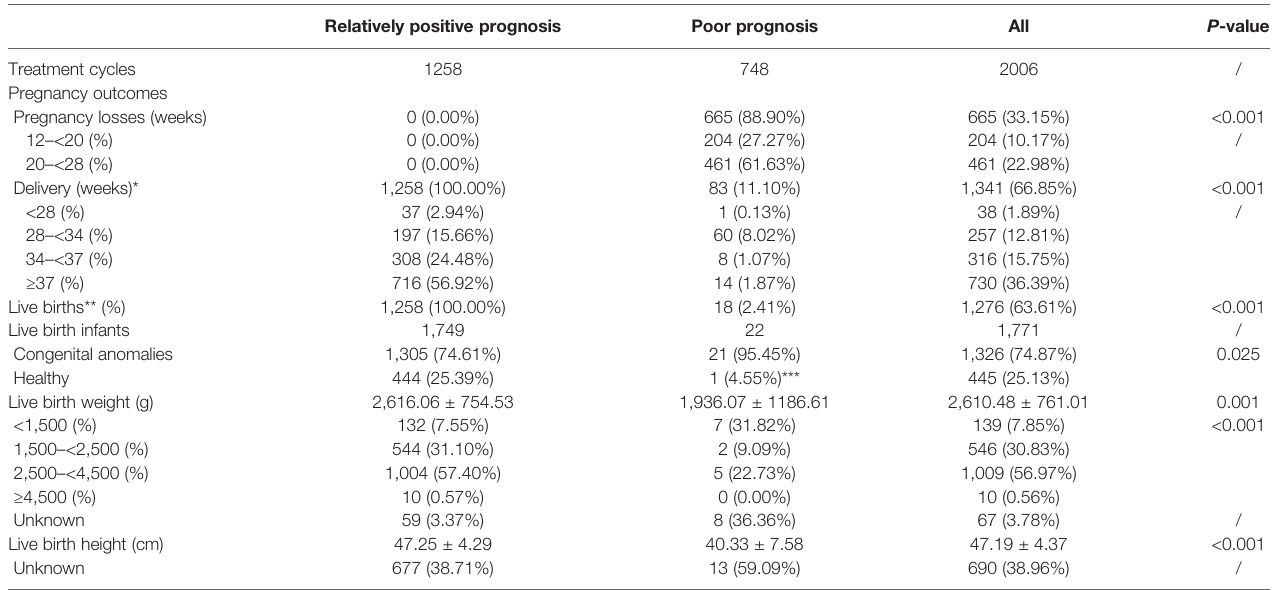
TABLE 4 | Clinical